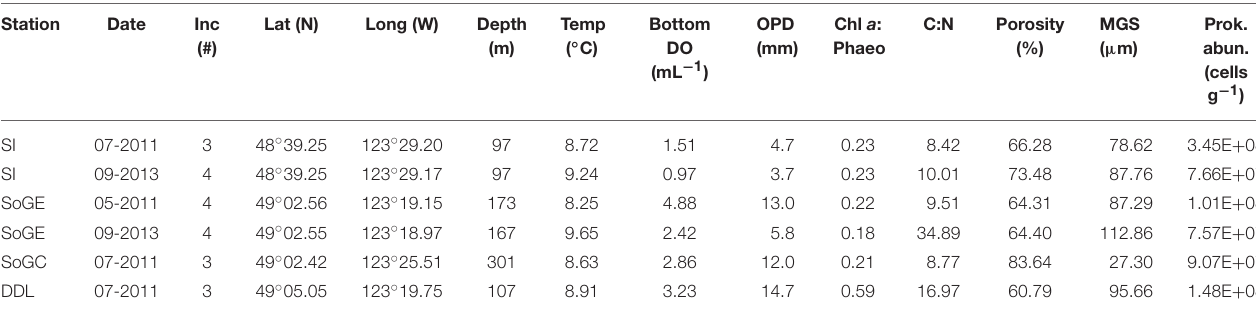
TABLE 1 | Station names, sampling dates, number of incubations performed, locations, and environmental variables